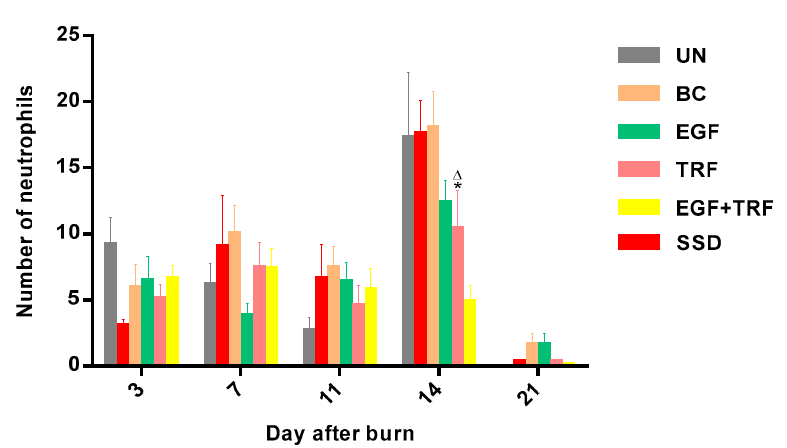
Figure 4. Number of neutrophils in all the groups over time post-burn . Note: Values calculated over a 21-day trial and expressed as mean ± S.E.M. for six rats. * p < 0.05 compared with those of the UN group on the respective day and ∆ p < 0.05 compared with those of the SSD group on the respective day.